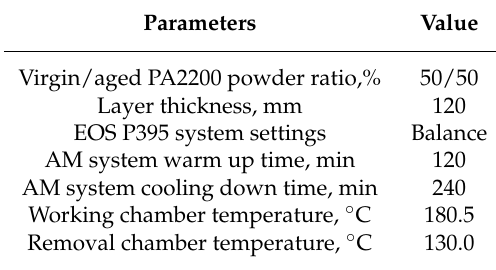
Table 1. Material and process parameters used in the